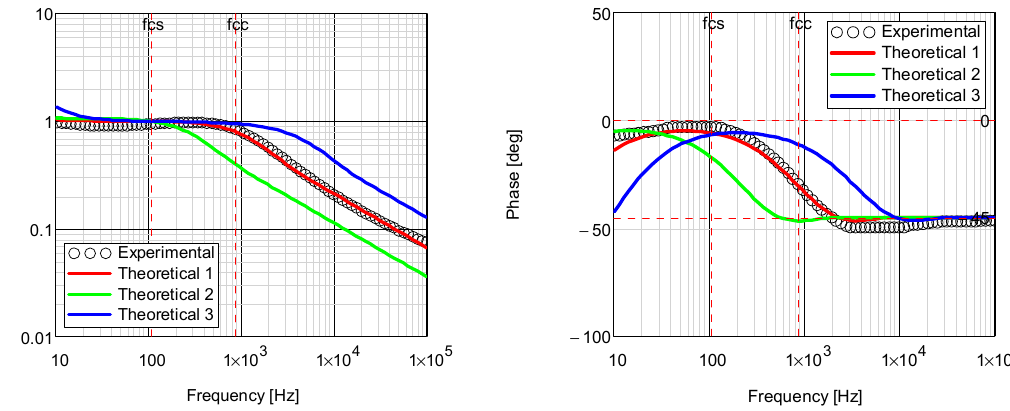
Figure 15. Theoretical and experimental PTR amplitude and phase characteristics obtained for the TMZ-III + Ce(NO 3 ) 3 sample.